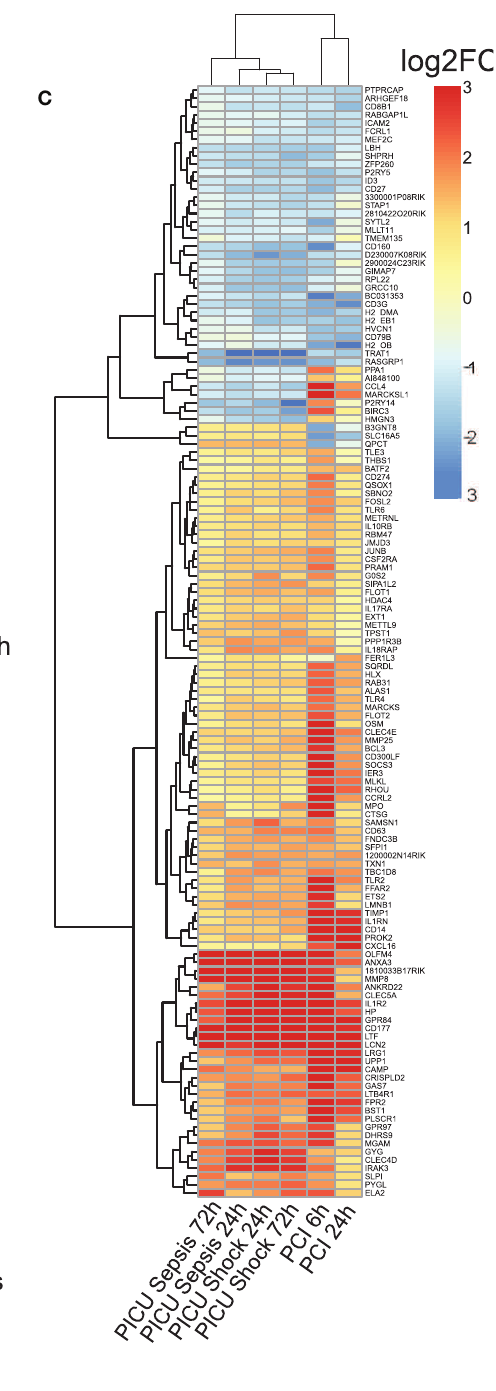
expressed (once in PCI and once in PICU). Features in the heatmap are annotated with gene symbols from M. musculus and average log2FC values (all adjusted to their respective controls) were pruned to be in [ − 3,